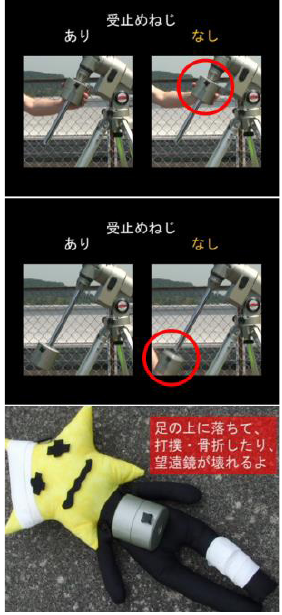
Figure 4. The risk of forgetting to tighten the thumbscrew of the counterweight shaft. Figure 3. The risk of unsafe attachment of counterweights